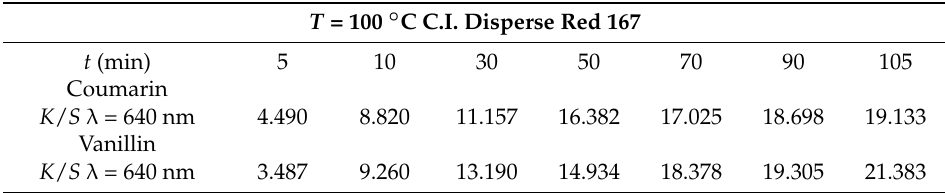
Table 3. K / S values for PES fabric dyed with D167 in presence of 0.666 g · L –1 of coumarin or o